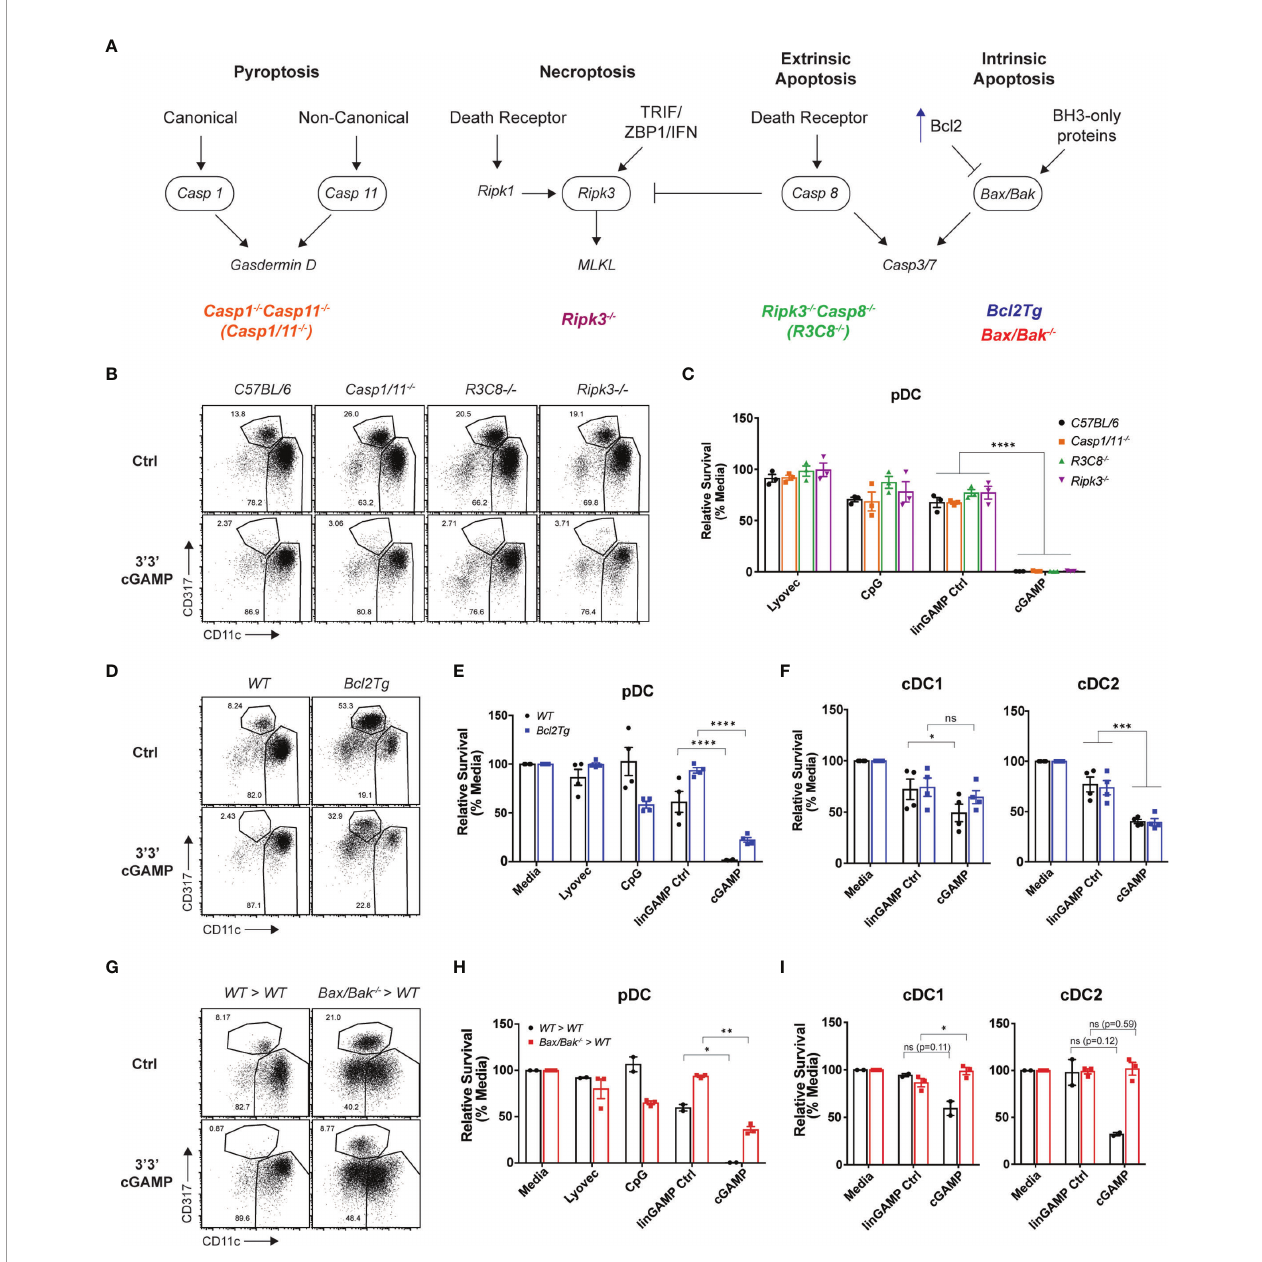
FIGURE 5 | Blocking intrinsic apoptosis partially inhibits STING-dependent pDC death and rescues cDC death. (A) Schematic diagram showing death signaling pathways: encircled components highlight deleted genes in mice upstream of effector proteins gasdermin D, mixed lineage kinase domain-like (MLKL) protein and caspase-3 and caspase-7. (B) FACS plots or (C) bar graphs show mean relative survival ± SEM from 3 individual mice per genotype from C57BL/6, Casp1/11 -/- , Ripk3 -/- Casp8 -/- (R3C8 -/- ) and Ripk3 -/- bulk splenic DCs stimulated with 10 nmol 3 ’ 3 ’ cGAMP or its linearized control ligand (linGAMP Ctrl) complexed with lyovec, lyovec alone or 0.5 m M CpG2216 for 18h. (D) FACS plots or (E, F) bar graphs from WT or Bcl2Tg bulk splenic DCs cultured with stimuli conditions as per (B) . Bar graph shows mean relative survival of (E) pDCs or (F) cDC subsets, mean ± SEM from 4 individual mice per genotype compiled from 2 independent experiments. (G) FACS plots and (H, I) bar graphs showing bulk splenic DCs from BM chimeras generated using Ly5.2 WT or Vav-Cre Bax -/- /Bak -/- mice cultured with stimuli conditions as per (B) . Bar graphs show Ly5.2 + relative survival of (H) pDCs or (I) cDC subsets, mean ± SEM from 2-3 individual mice per genotype. Statistical analysis was performed using (C) two-way ANOVA using Tukey ’ s test to correct for multiple comparisons or (E, F, H, I) two-tailed Paired Student ’ s t test where *P < 0.05 , **P < 0.01 , ***P < 0.001, ****P < 0.0001 and ns, not signi fi